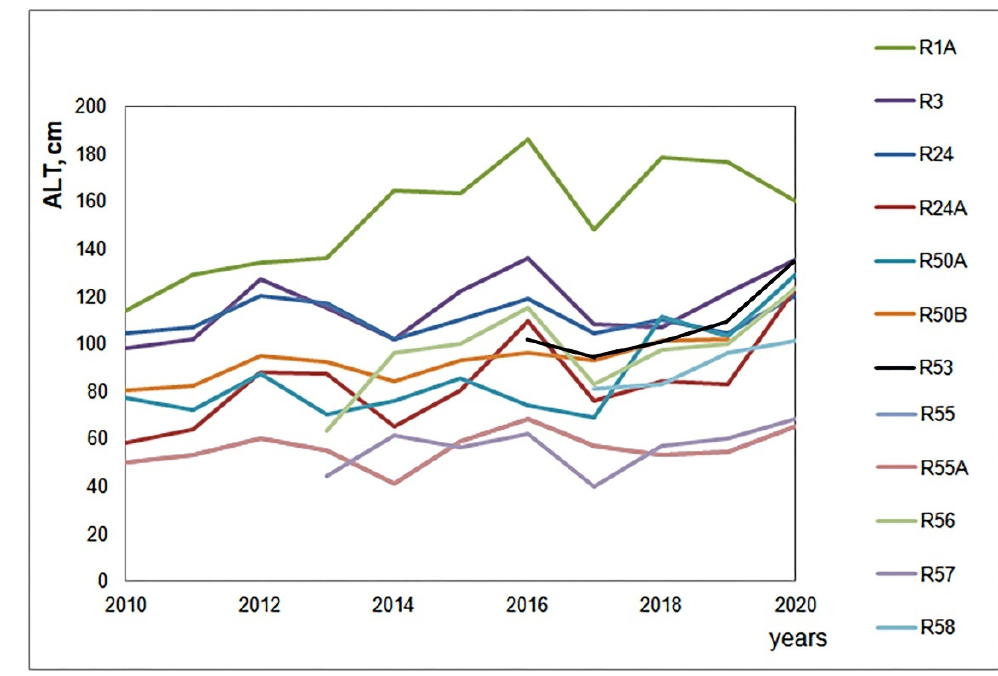
Figure 5. Interannual variability of average thaw depth at CALM sites [46] . Table 3. Seasonal thawing depth values averaged for each site [46] .